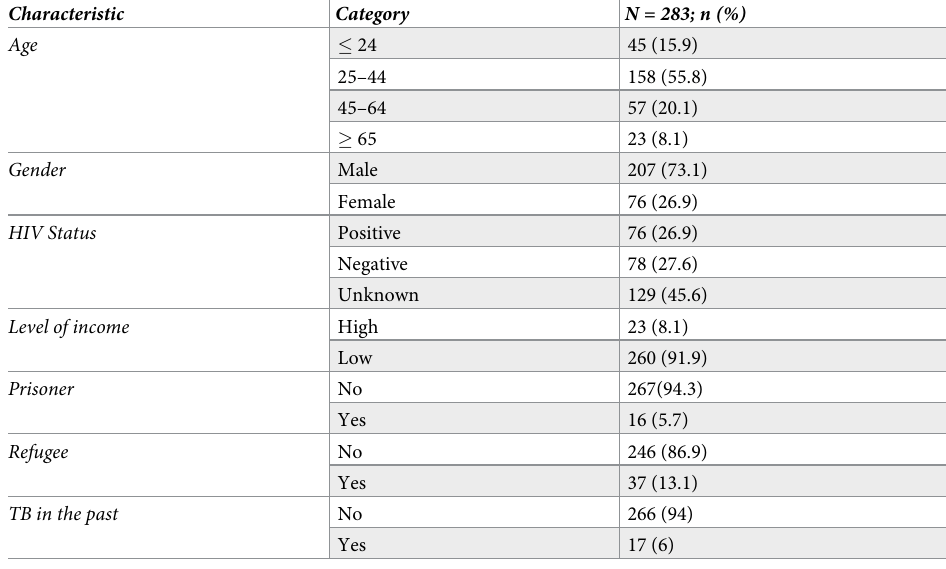
Table 1. Demographic characteristics of patients enrolled for the study between May 2018 and April